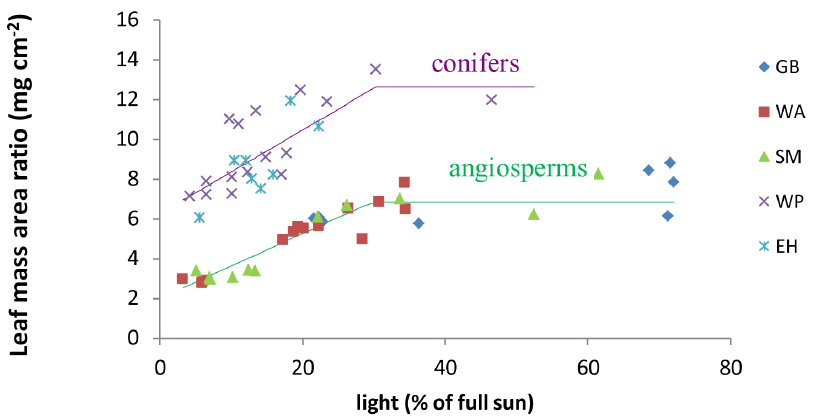
Figure 4. Relationship between leaf mass area ratio (LMA, mg/cm 2 ) and leaf-level irradiance. For both angiosperm and conifer species, LMA can be expressed as a linear function of light (L, % of full sun) when light is less than 30%. For angiosperm species, the expression is LMA=0.163*L + 1.997 (R 2 =0.85, P ,, 0.001); and the expression for conifer species is LMA=0.233 *L + 6.044 (R 2 =0.45, P ,, 0.001). The plateau values of LMA when light is above about 30% are 6.83 mg/cm 2 for angiosperm species, and 12.64 mg/cm 2 for conifer species. Species code: GB=gray birch,